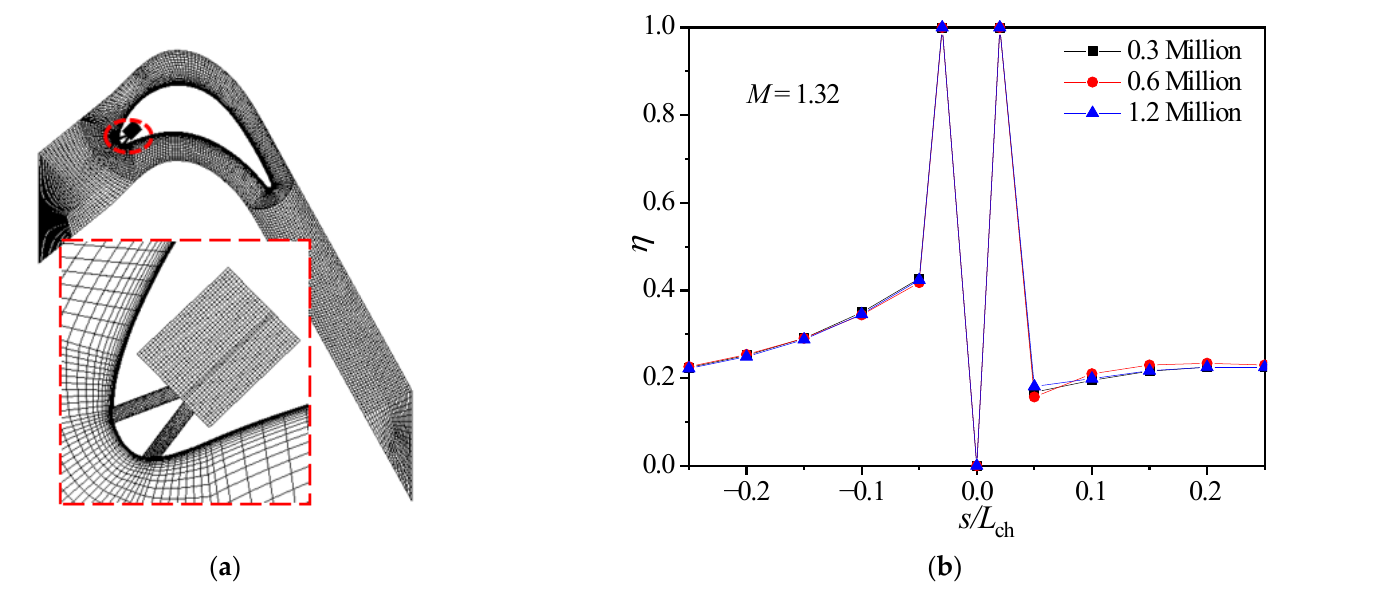
Figure 2. Grid independence study. ( a ) Mesh view, ( b ) centerline film cooling effectiveness.